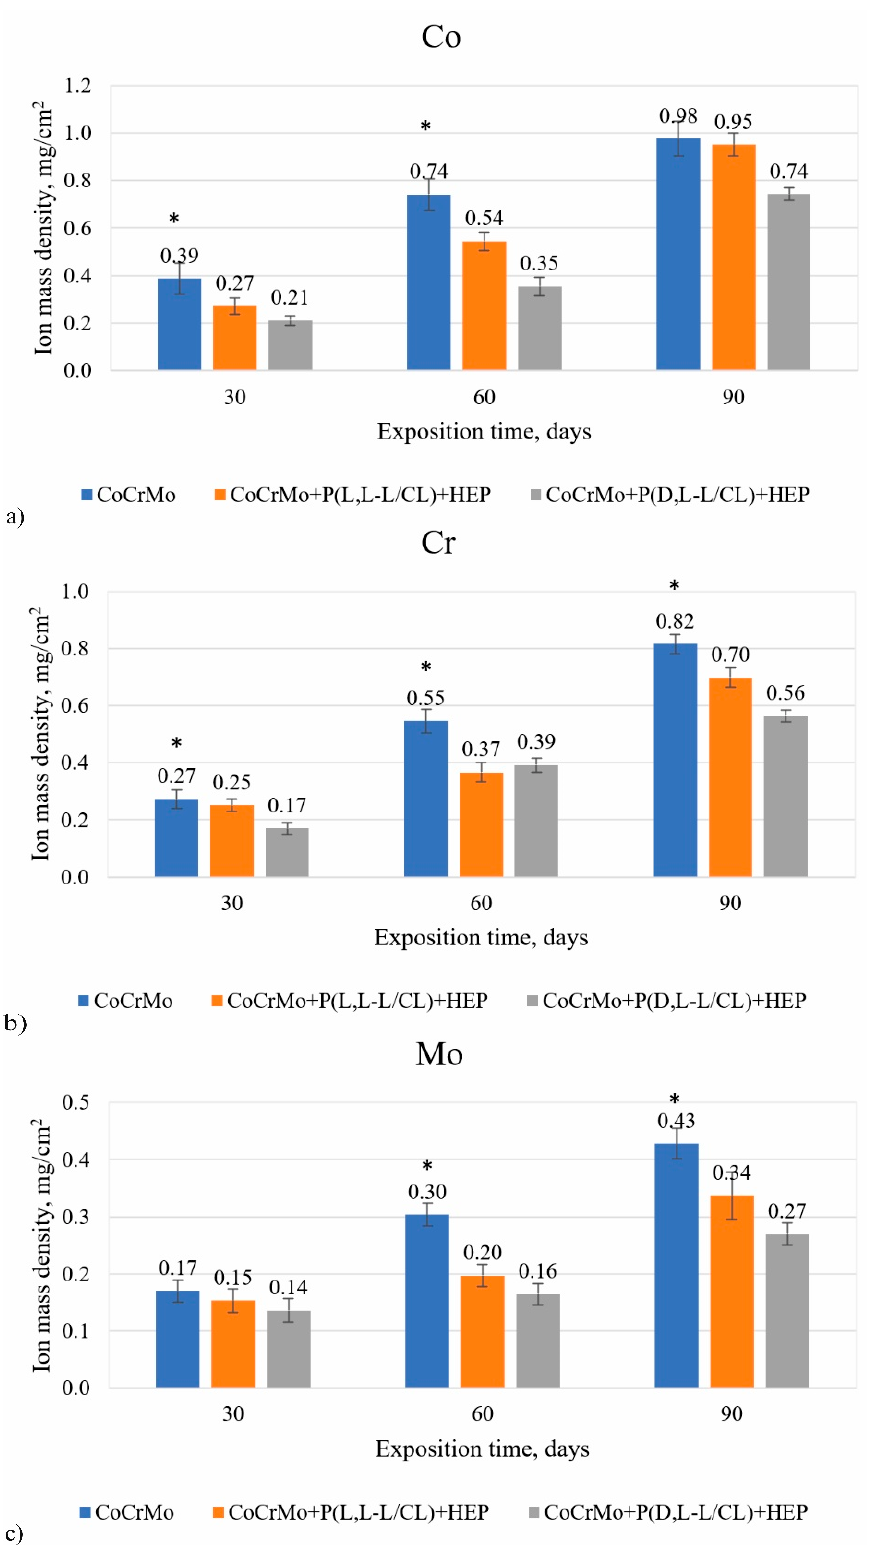
Figure 8. Comparison of the mass density of ions released into the artificial urine for ( a ) cobalt; ( b ) chromium; ( c ) molybdenum (* p < 0.05 versus the control group).